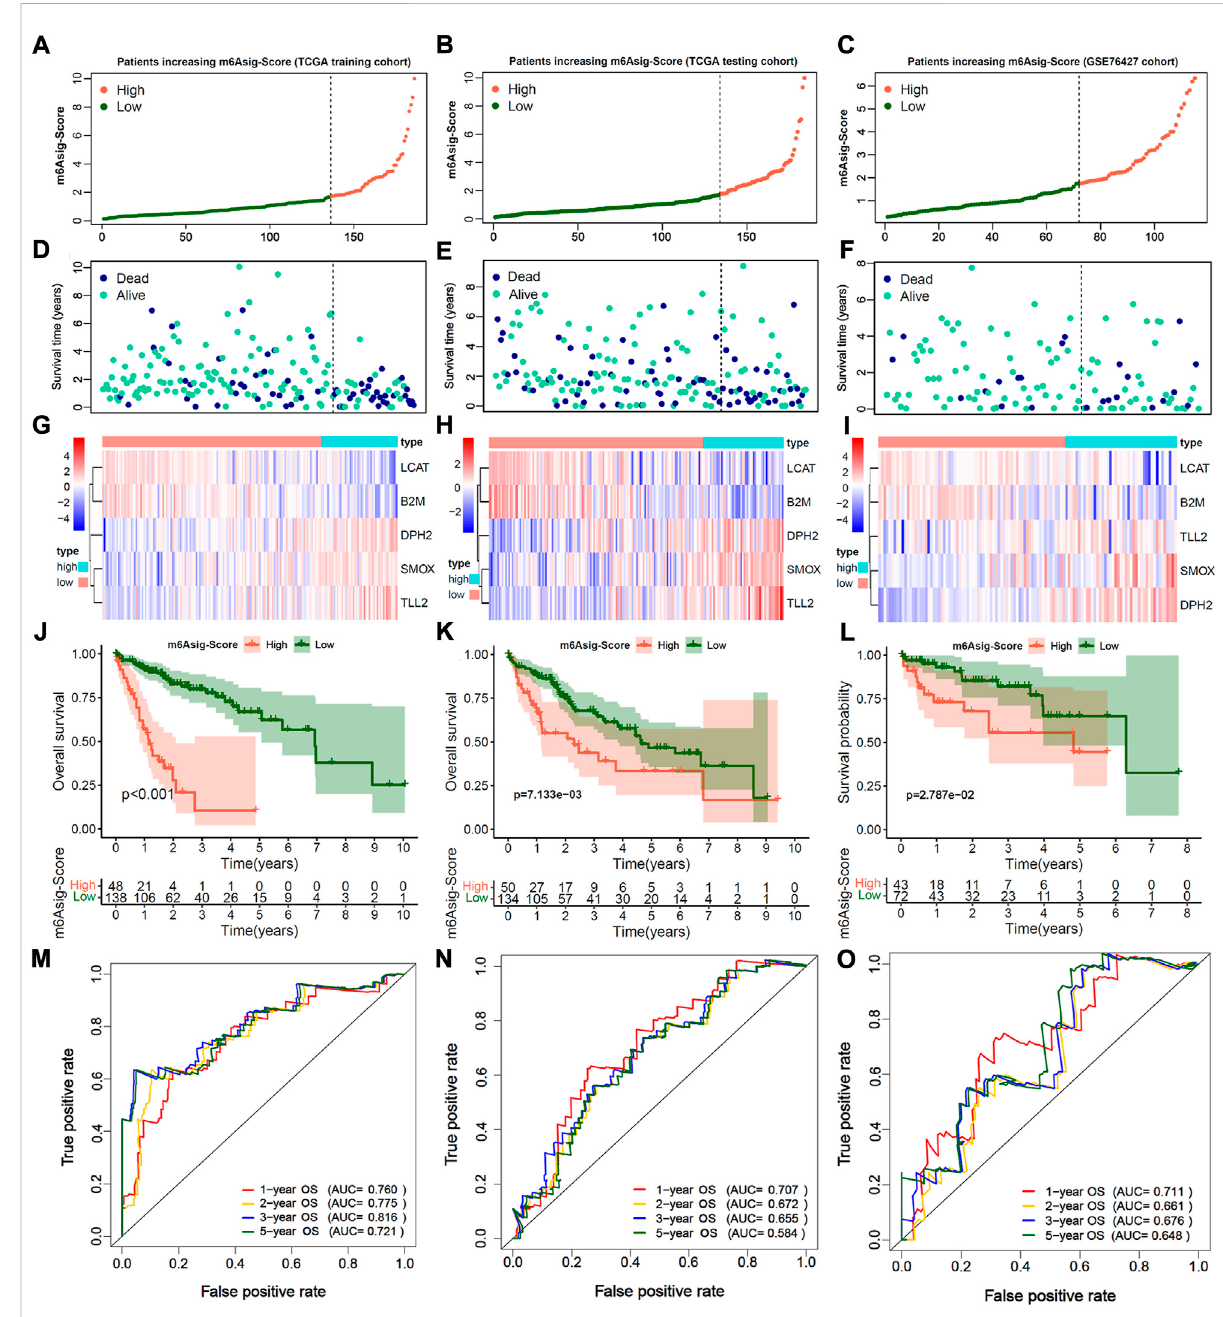
FIGURE 5 Estimation and validation of m6A signi fi cant score (m6Asig-Score). (A – C) The assessment of risk for m6Asig-Score in three distinct HCC cohorts, different colors of curves represented risk score. High risk was presented in tomato, and low risk was in green. (D – F) The plots of different colors and locations represented OS status and survival time in three HCC distinct cohorts. Blue, dead; green, alive. (G – I) The heatmap indicates 5 hub genes expression between high and low m6Asig-Score in three distinct HCC cohorts. (J – L) Kaplan-Meier analysis of overall survival (OS) for high and low m6Asig-Score groups in three distinct HCC cohorts. (M – O) Time-ROC curves of 1-, 2-,3-, and 5-year OS in three distinct HCC